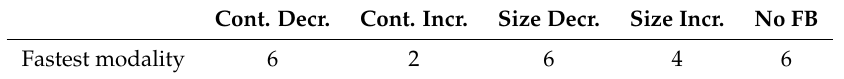
Table 3. The number of subjects for whom the specific feedback method resulted in the highest ITR. Cont.